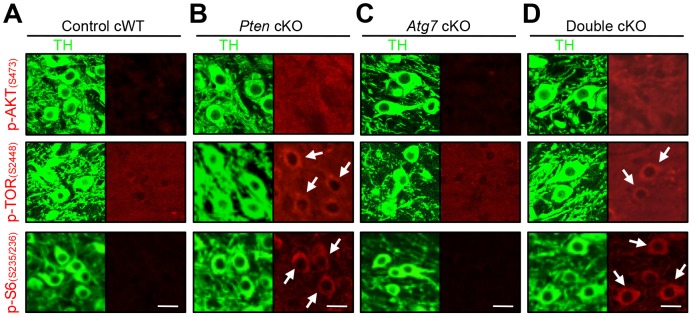
Characterization of PI3K/mTOR pathways in TH-positive DA neurons of Atg7 and/or Pten cKO mice.PI3K/mTOR pathway signaling, in terms of accumulation of phospho-AKT (S473), phospho-TOR (S2448), and phospho-S6 (S235/236) as indicated (in red) were unchanged in the TH-positive (green) midbrain DA neurons of Atg7 cKO mice (C), whereas these markers were increased in TH-positive DA neurons of Pten cKO and Atg7/Pten double cKO mice (arrows in B and D). (A) Control cWT mice, (B) Pten cKO mice, (C) Atg7 cKO mice, and (D) Atg7/Pten double cKO mice. Scale bars, 10 µm.